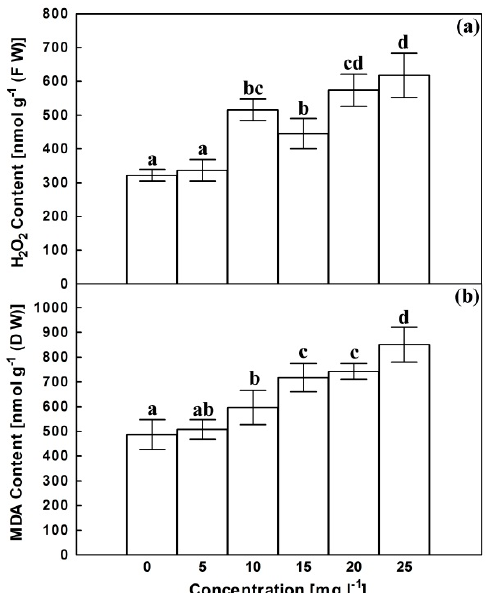
Figure 2. Effects of AgNPs at concentrations of 5, 10, 15, 20 and 25 mg L − 1 on H 2 O 2 content ( a ) and MDA content ( b ) of C. roseus cell suspension cultures. Means ± standard deviations (SDs), n = 3, Values followed by the same small letter within each column are not significantly different at p ≤ 0.05.